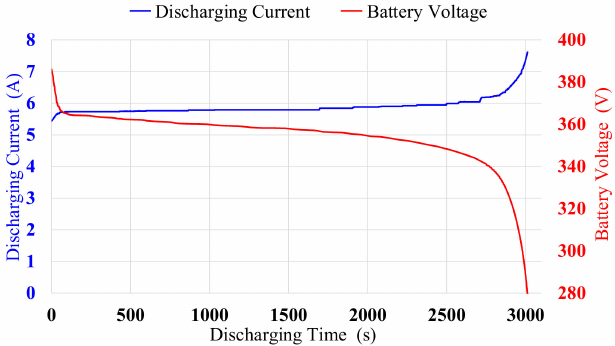
Figure 22. Constant power discharging curve of the fabricated